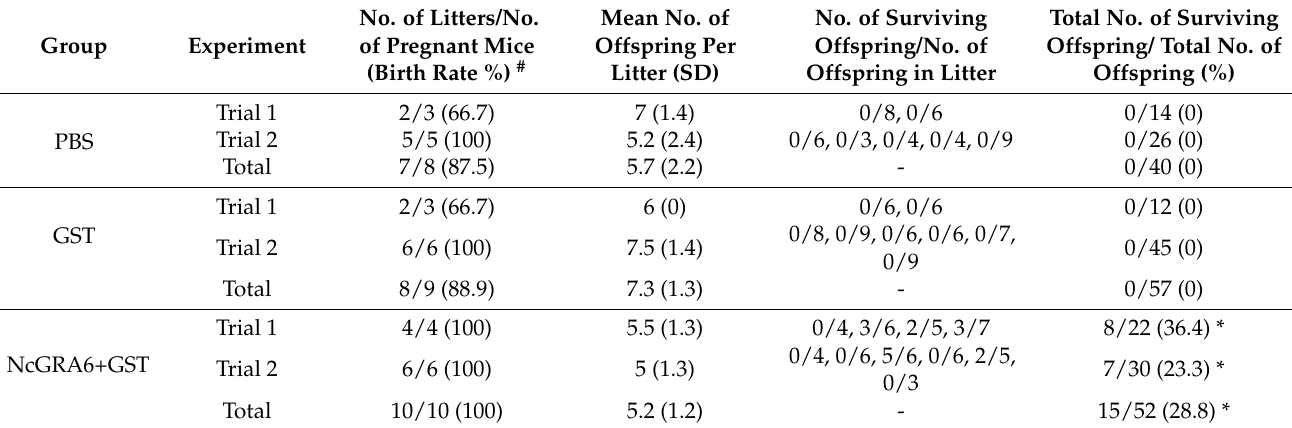
Table 1. Protection of Neospora caninum dense granule protein 6 (NcGRA6) vaccine against N. caninum infection in pregnant BALB/c mouse model.